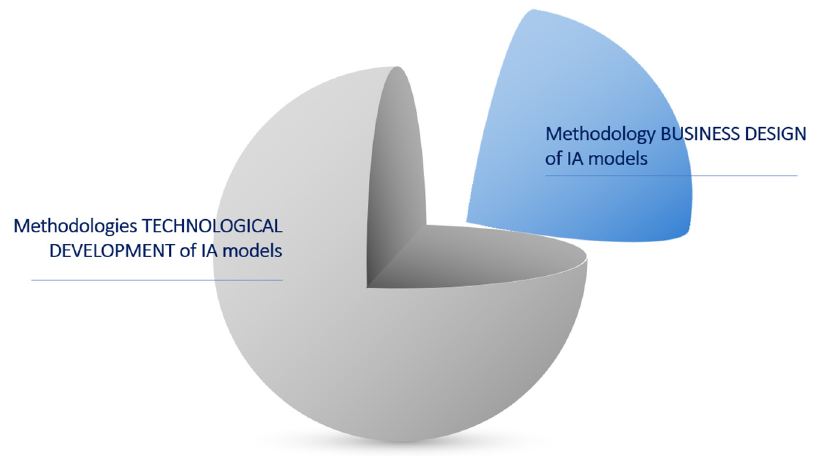
Figure 7. 360° approach to Model AI development . Source: own elaboration.